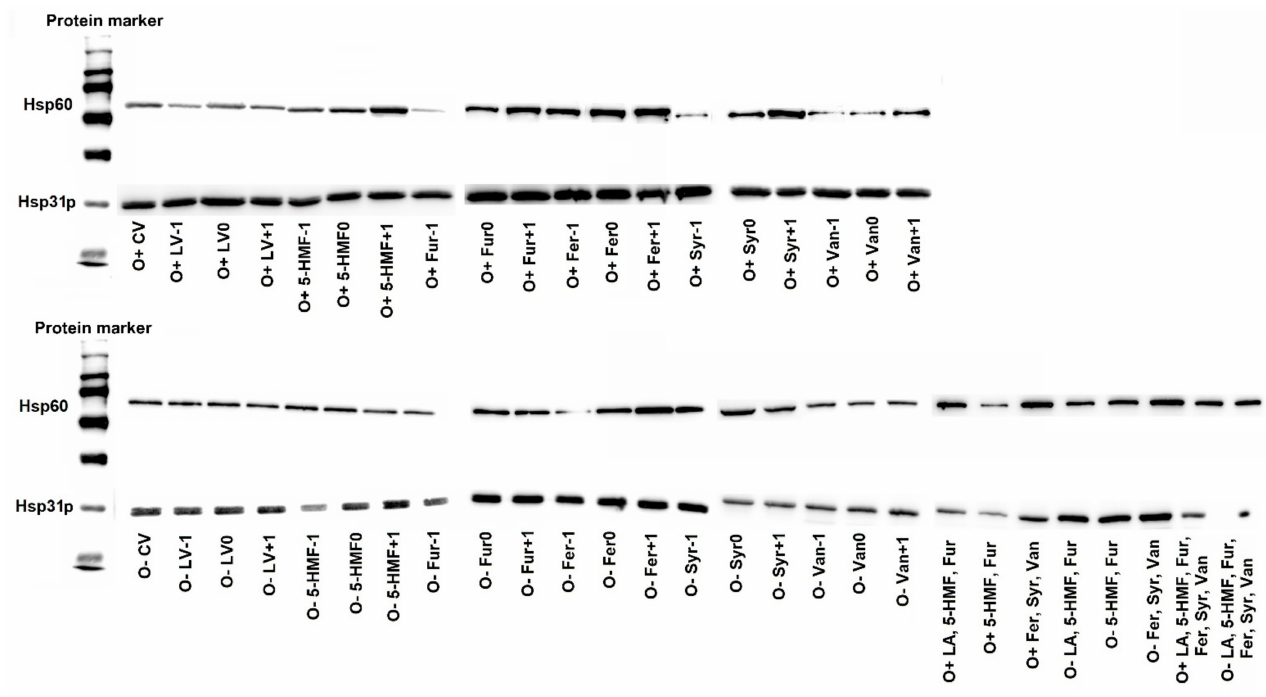
Figure 8. Effect of lignocellulose pretreatment by-products on the production of Hsp30p and Hsp60 by yeast (20 µ g of protein per